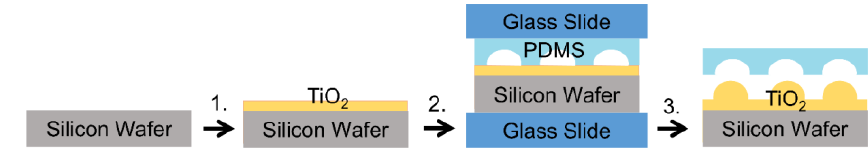
Figure 9. Schematic of the TiO 2 nanoimprinting process. ( 1 ) TiO 2 film is spin-coated on silicon substrate using a precursor titanium diisopropoxide bis(acetylacetonate); ( 2 ) The polydimethylsiloxane (PDMS) stamp having nanocups is placed on the spin-coated film with patterned side facing the film. The whole assembly is sandwiched between two glass slides and held together with binder clips (not shown here); ( 3 ) After keeping at ~170 °C for 15 min, the binder clips are released to reveal the inverse of PDMS nanocups on the TiO 2 film.